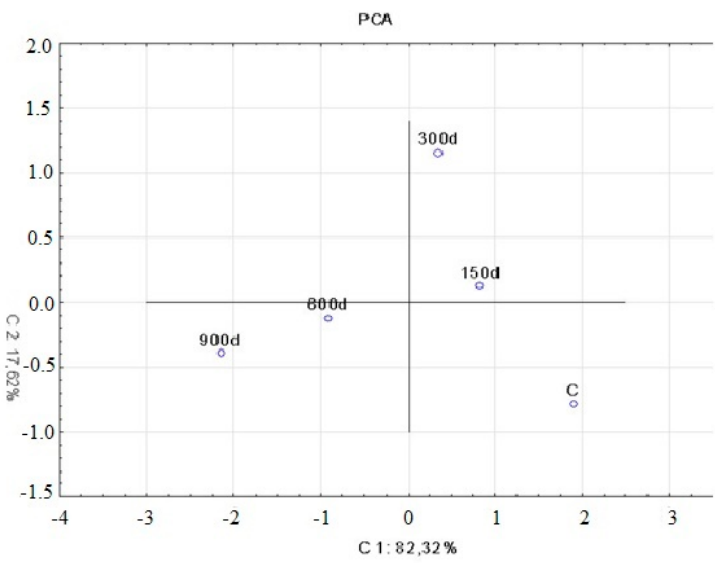
Figure 8. Graph of principal-component analysis for imagoes.